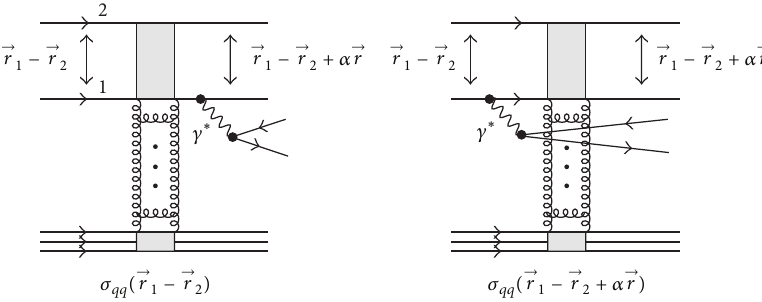
Figure 7: Leading order contribution to the diffractive Drell-Yan in the dipole-target collision.